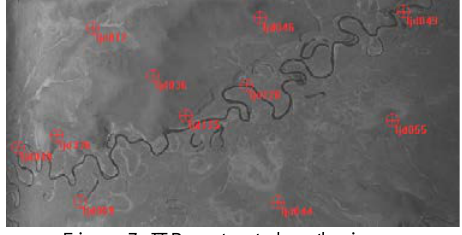
Figure 7. ITPs extracted on the image